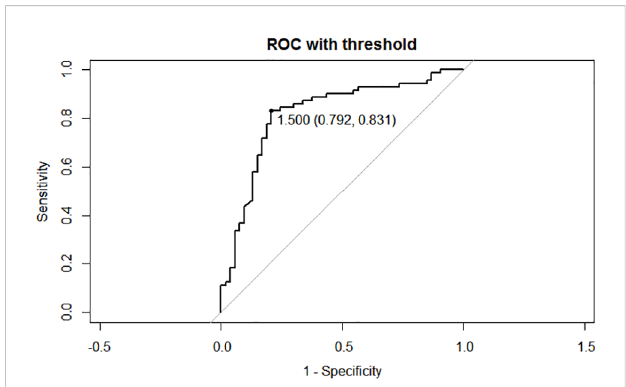
FIGURE 2 Receiver operating characteristic (ROC) curves of the cut-off of D s-Tg/ D s-